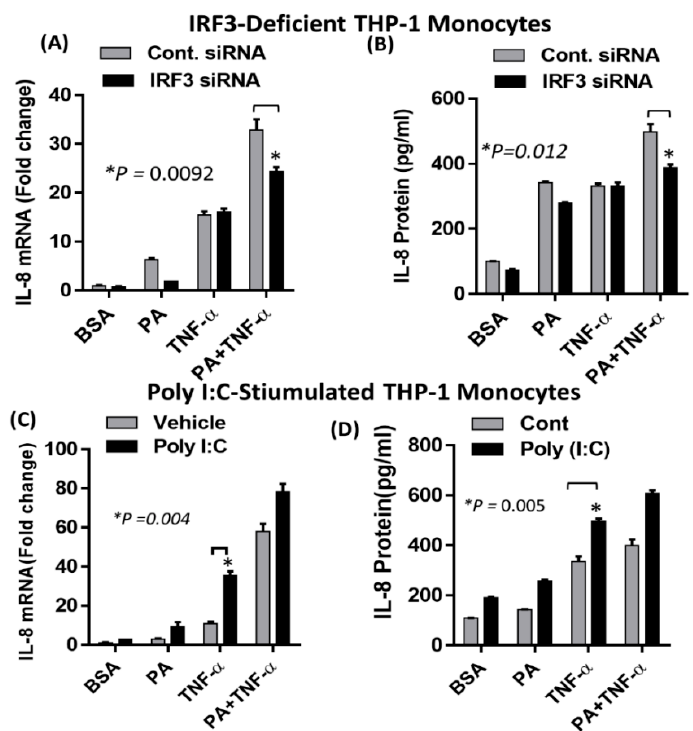
Figure 7. Synergistic production of IL-8 by palmitate / TNF- α requires IRF3. ( A , B ) Monocytes were transfected with IRF3 siRNA or control and incubated for 40 h. IRF3-deficient cells were treated with PA, TNF- α or a combination of PA and TNF- α . ( C , D ) Monocytes were treated (via transfection) with poly I:C (5 µ g) for 2 h and then incubated with PA or TNF- α or combination of PA and TNF- α for 24 h. IL-8 mRNA expression was measured by real-time PCR and IL-8 protein was quantified by ELISA. The results obtained from three replicates of each experiment are shown. All data are expressed as mean ± SEM. *Indicates significant difference.